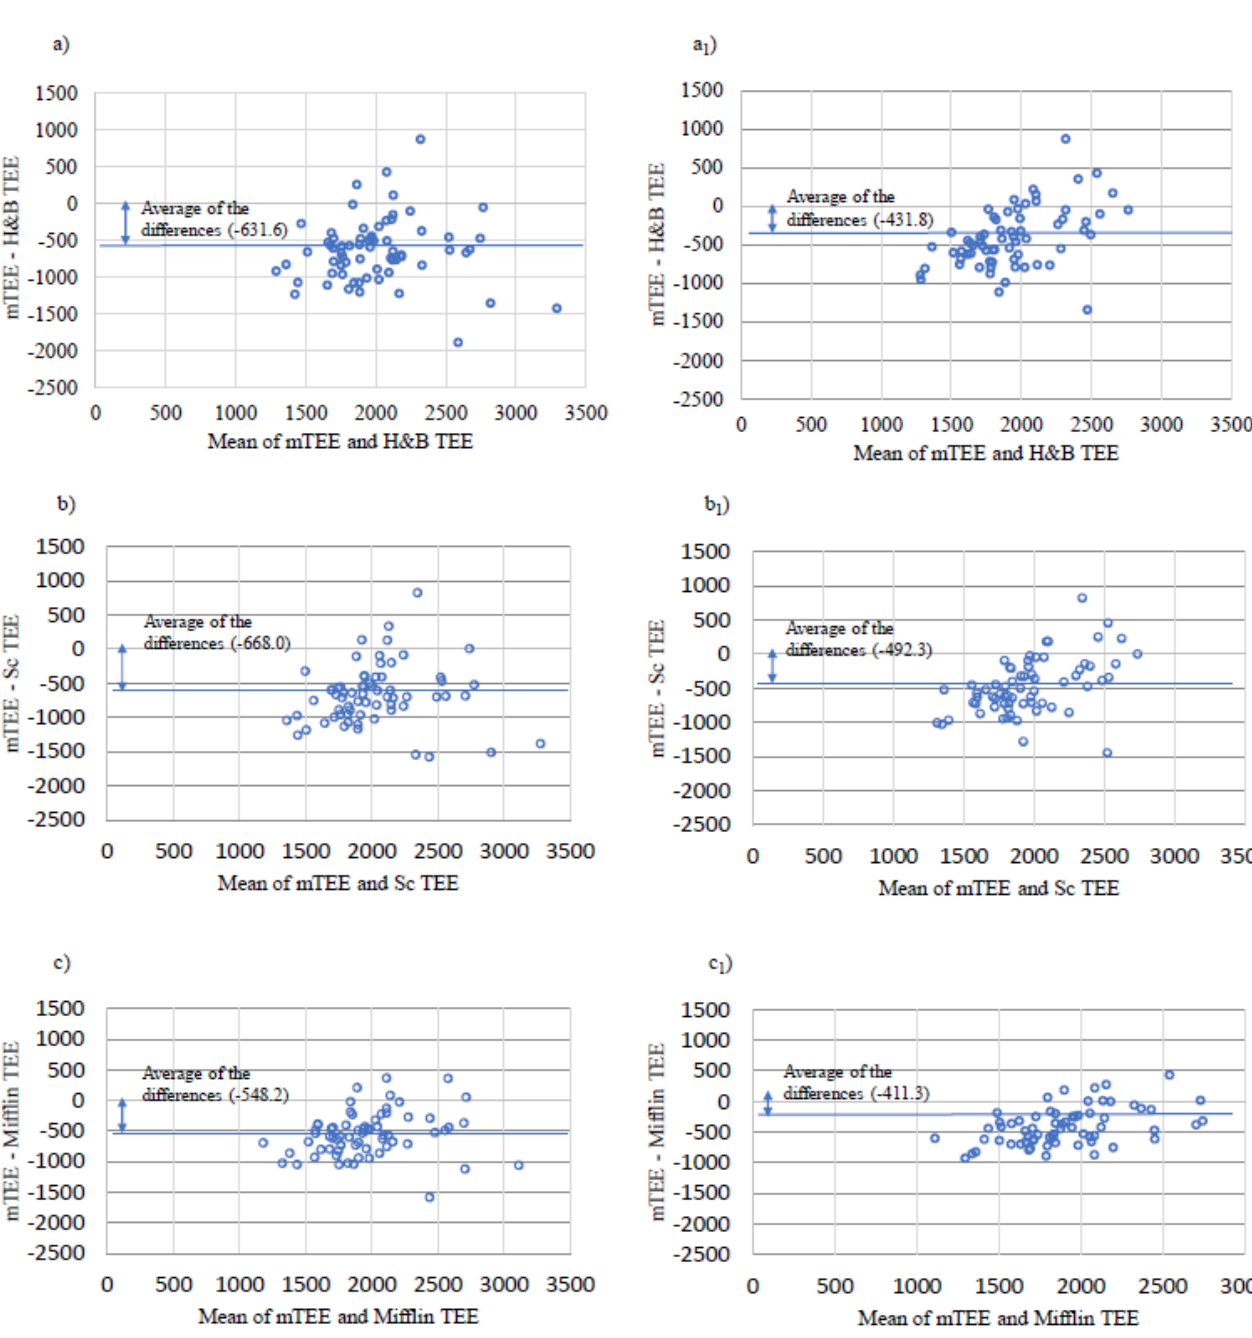
Figure 2. Bland–Altman plots. mTEE: total energy expenditure measured by Indirect calorimetry *adMETs as assessed by the Sensewear Armband) H&B TEE: total energy expenditure estimated by the Harris–Benedict equation *PAL; Sc TEE: total energy expenditure estimated by the Schoffield equation *PAL; Mifflin TEE: total energy expenditure estimated by the Mifflin equation *PAL using actual body weight ( a – c ) and using ideal body weight ( a 1 – c 1 ) in the predictive equations .